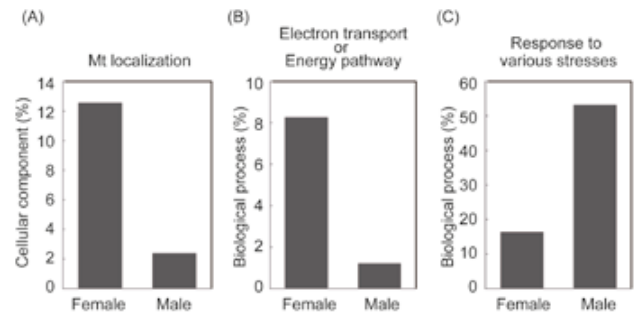
Fig. 2 - Abundant mitochondria are present in the spadix of thermogenic skunk cabbage. (A) Female spadix cells (petal tissues) contain many mitochondria. This photograph was adapted from Fig. 5A in our previous paper (Ito-Inaba et al ., 2009a). In this study, large numbers of mitochondria were also observed in pistils and in several tissues in stamens. (B) Quantitative comparison of mi- tochondrial protein amount from thermogenic and non-thermo- genic stages or tissues. Female-stage spadices ( ♀ ) in S. renifolius (Sr) contain 2-fold and 50-fold higher content of mitochondria than male spadices ( ♂ ) and or spadices from L. camtschatcensis (Lc), respectively. Data was extracted from Table 2 and Table 1 in our previous papers (Ito-Inaba et al ., 2009 a, b, respectively).